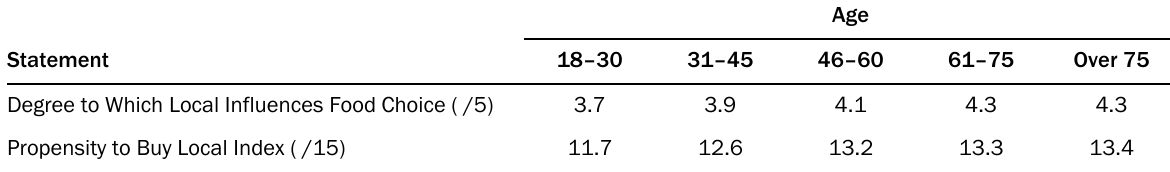
Table 6. Propensity to Buy Local Foods By